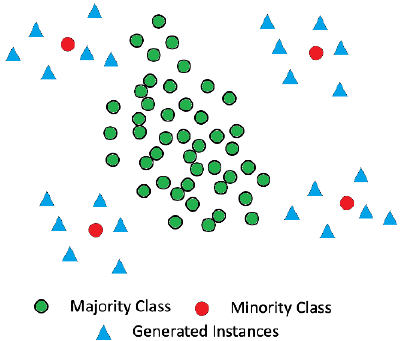
Figure 2. An example of oversampling by the G-SMOTE algorithm.